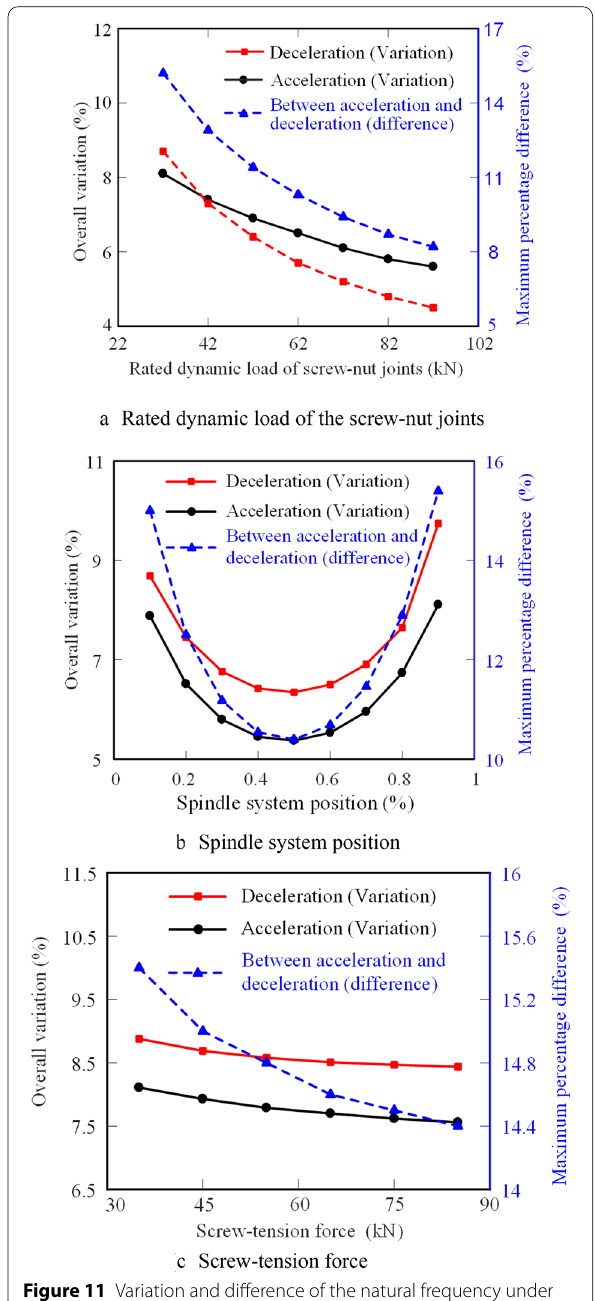
Figure 11 Variation and difference of the natural frequency under the effect of different